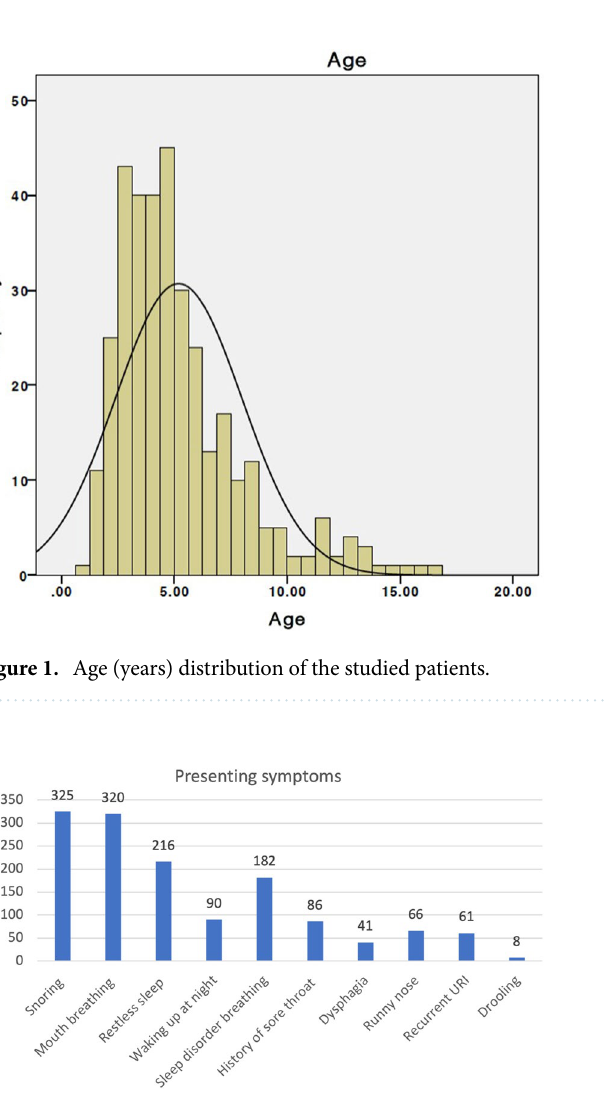
Figure 2. Presenting symptoms of the children undergoing Coblation-assisted adenotonsillar